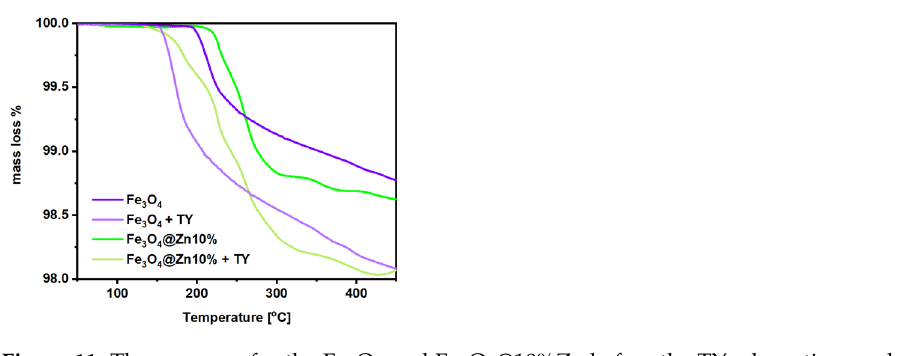
Figure 11. Thermogram for the Fe 3 O 4 and Fe 3 O 4 @10%Zn before the TY adsorption, and after the dye adsorption onto SPION surfaces.